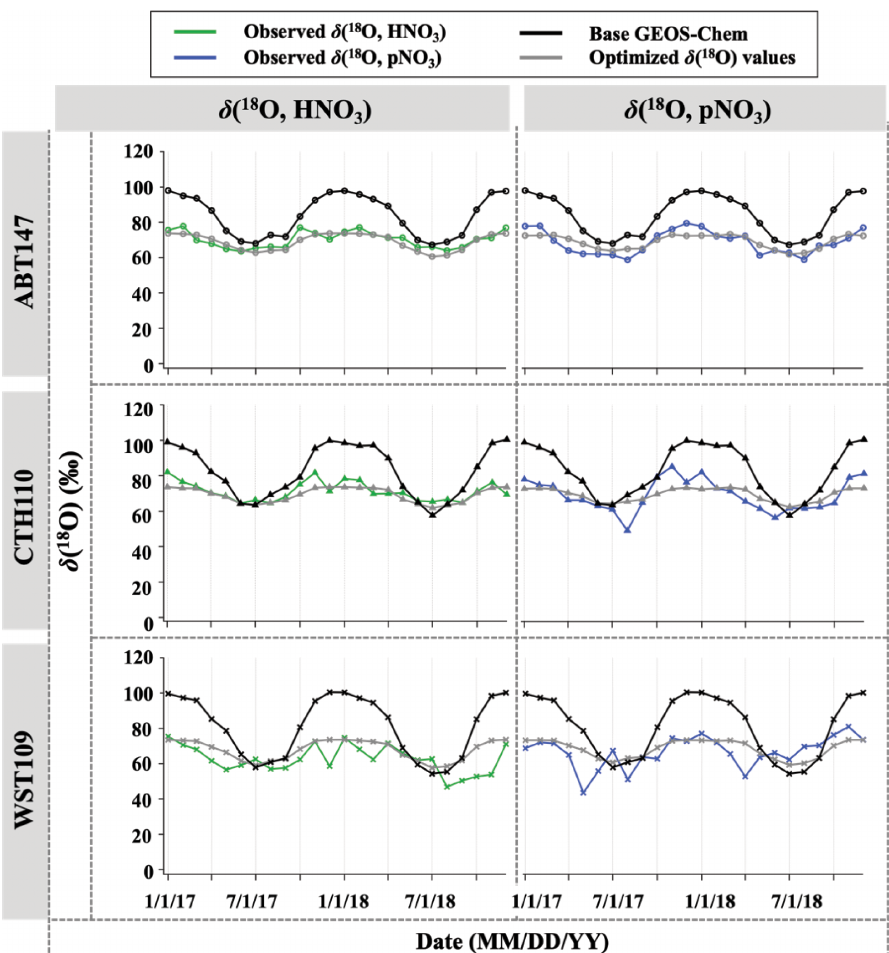
Figure 10. Time series of observed and calculated δ ( 18 O) for HNO 3 and pNO 3 for ABT147, CTH110, and WST109 sites. Calculated δ ( 18 O) using base GEOS-Chem (black) and using optimized δ ( 18 O) values (gray) are shown in the plot